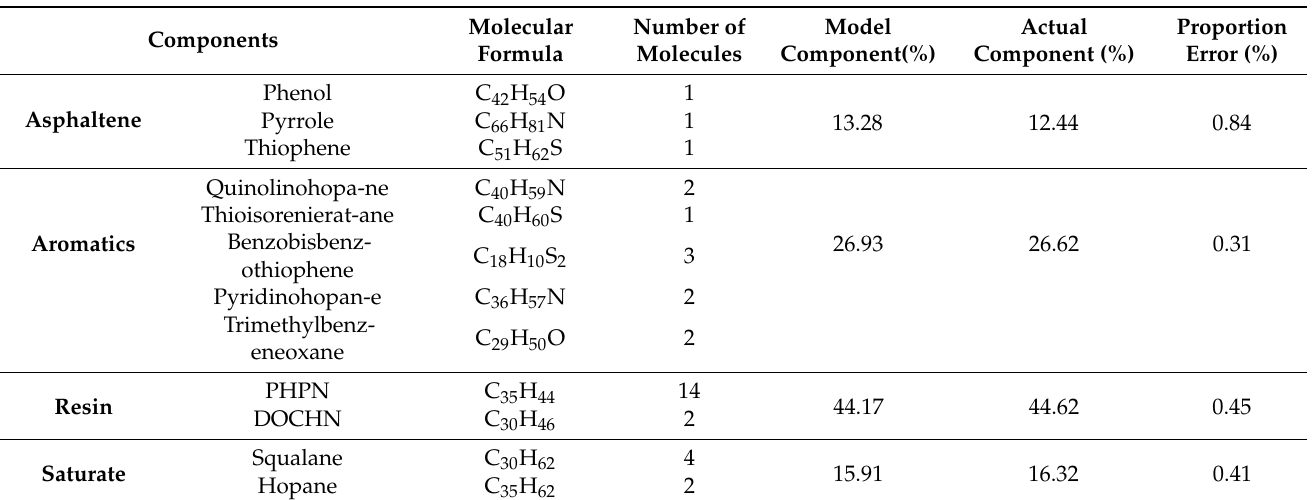
Table 3. Model parameters of 12-component base asphalt.